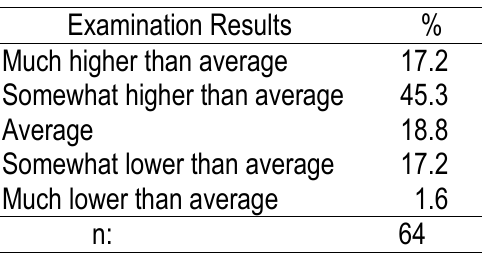
Table 1. Mid-term examination results of